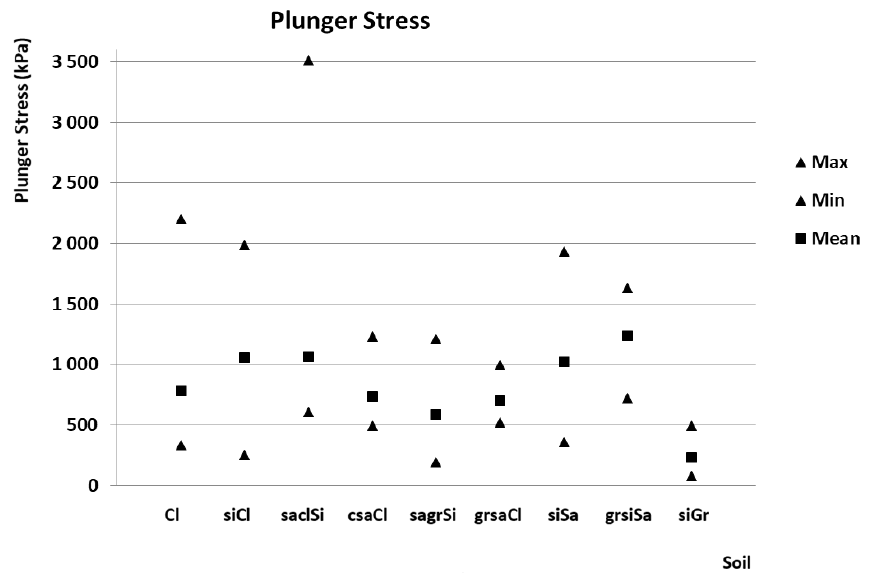
Figure 2. Plunger stress for individual soil classes.